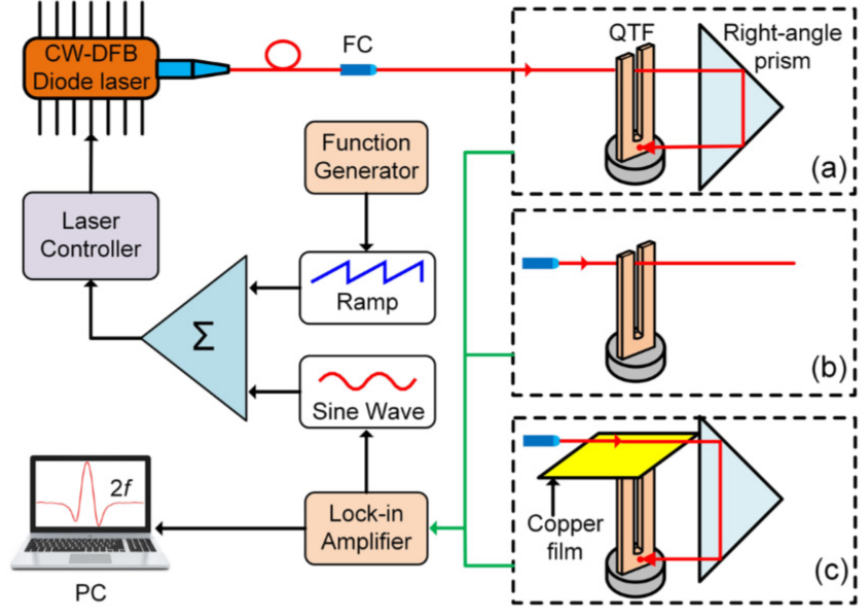
Figure 6. ( a ) S-QEDS sensor system configuration. ( b ) QEPAS sensor system configuration. ( c ) LITES sensor system configuration. QTF: quartz tuning fork; FC: fiber collimator; PC: personal computer. Reprinted/adapted with permission from Ref. [105]. Copyright 2021, copyright The Optical Society.